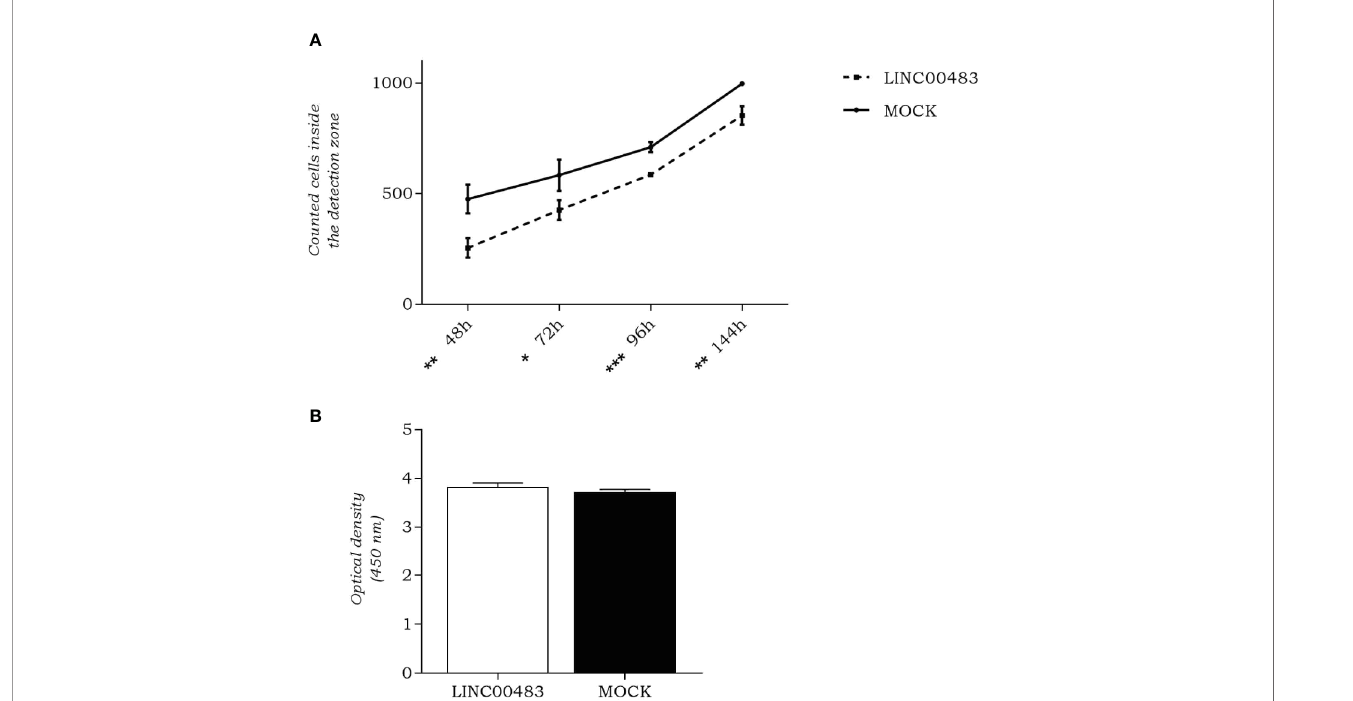
FIGURE 4 | LINC00483 functional assays. (A) Number of cells migrated into the detection zone in transfected HCT-116 cells compared to negative controls (MOCK), at 48, 72, 96, and 144 h after transfection. *p-value < 0.05; **p-value < 0.01; ***p-value < 0.001; (B) CCK-8 assay was performed to assess HCT-116 cell proliferation at 48 h after LINC00483